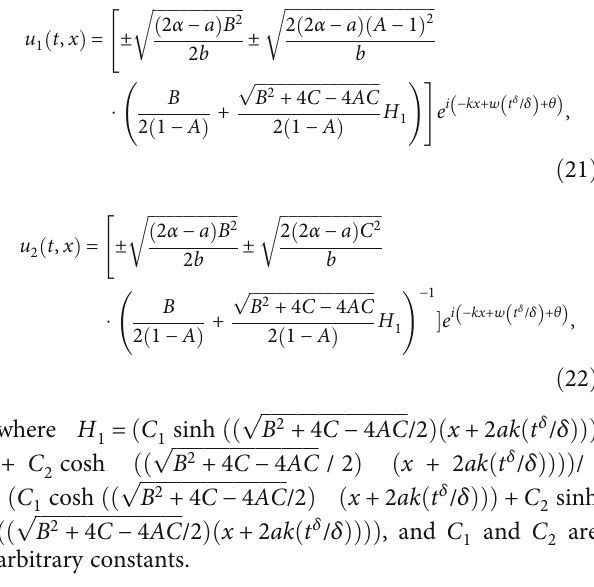
Figure 2: The positive real part of u (23) for di ff erential values of the fractional parameter δ